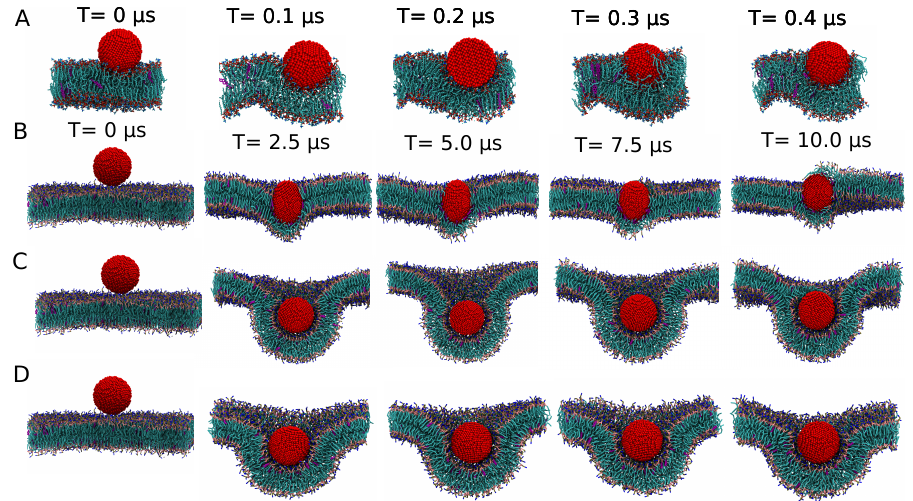
Figure 4. Selected snapshots showing the evolution of a 5 nm NP interacting with a lipid membrane composed of DPPC, DOPC, POPC and cholesterol in 5:2:2:1. Different resolutions and different CG bead type combinations in the core-shell model are shown: ( A ) for the reference all-atom representa- tion of an Ag NP, ( B ) uniform C C 5 -S C 5 CG representation, ( C ) uniform C C 2 -S C 2 CG representation and ( D ) target C C 5 -S C 2 CG representation of an Ag NP. As the nature of the lipids is not crucial at this stage, all lipids are shown as blue sticks and cholesterol in pink sticks, while each atom (AAMD) or bead (CGMD) in the NP is represented with a red sphere. The reference snapshots of unconstrained AAMD–see panel A—were obtained in a previous atomistic study for a smaller system [35], and are only added here to enable a direct visual comparison with the new CGMD